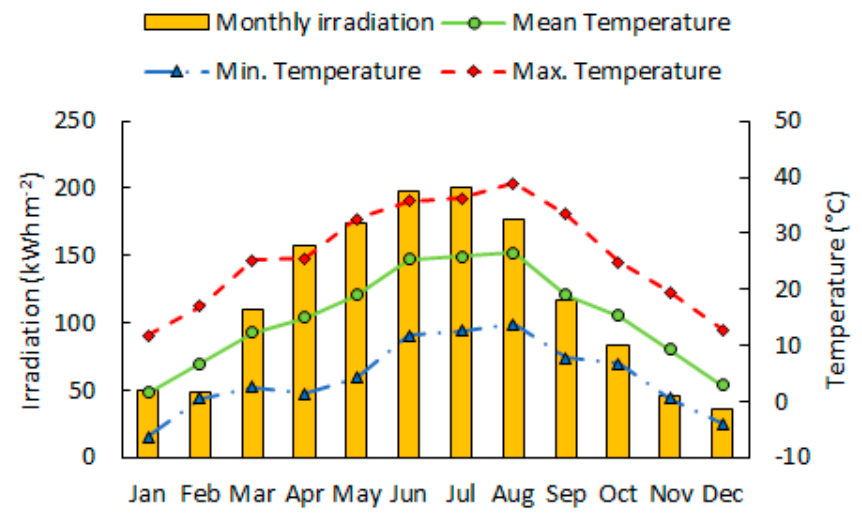
Figure 8. Monthly solar irradiation on the horizontal plane and outdoor temperatures.